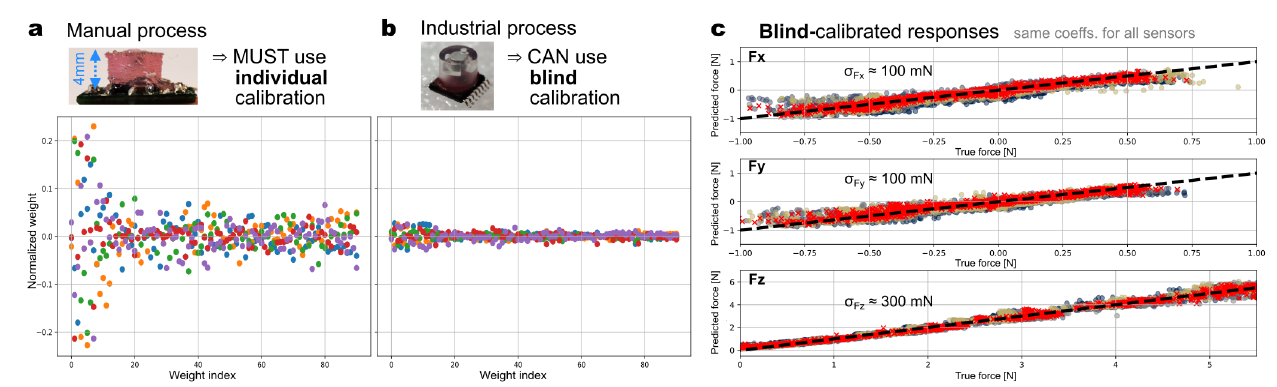
Figure 8. Normalized calibration coefficients (mean normalized weights: w i − w i ) of the F z calcu- lation model F z = Σ i w i x i for 5 sensors (each sensor corresponds to a different color). ( a ) Sensors with the elastomer fabricated manually (prior work), resulting in substantial part-to-part variability. ( b ) Sensors with the elastomer fabricated industrially (this work). The dispersion is under con- trol. ( c ) Force responses (predicted versus ground truth) of 5 sensors with the elastomer fabricated industrially and blindly calibrated (same coefficients w i used for all